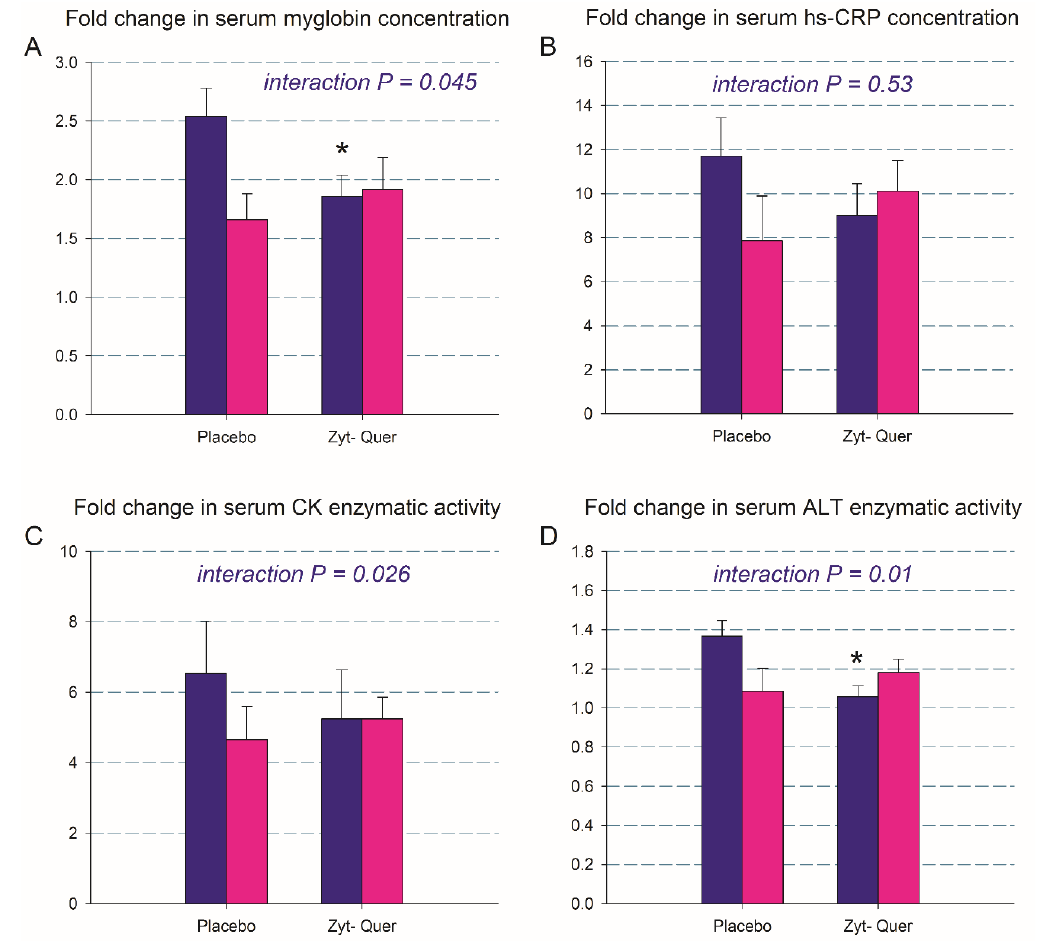
Figure 4. Changes in biomarkers of muscle damage 24 h after a 10 km running competition followed by 100 drop jumps. * p < 0.05 compared with placebo. Interaction refers to time by treatment by sex (men: purple; women: pink). The error bars represent the standard error of the mean. Placebo, N = 22; polyphenols, N = 24.